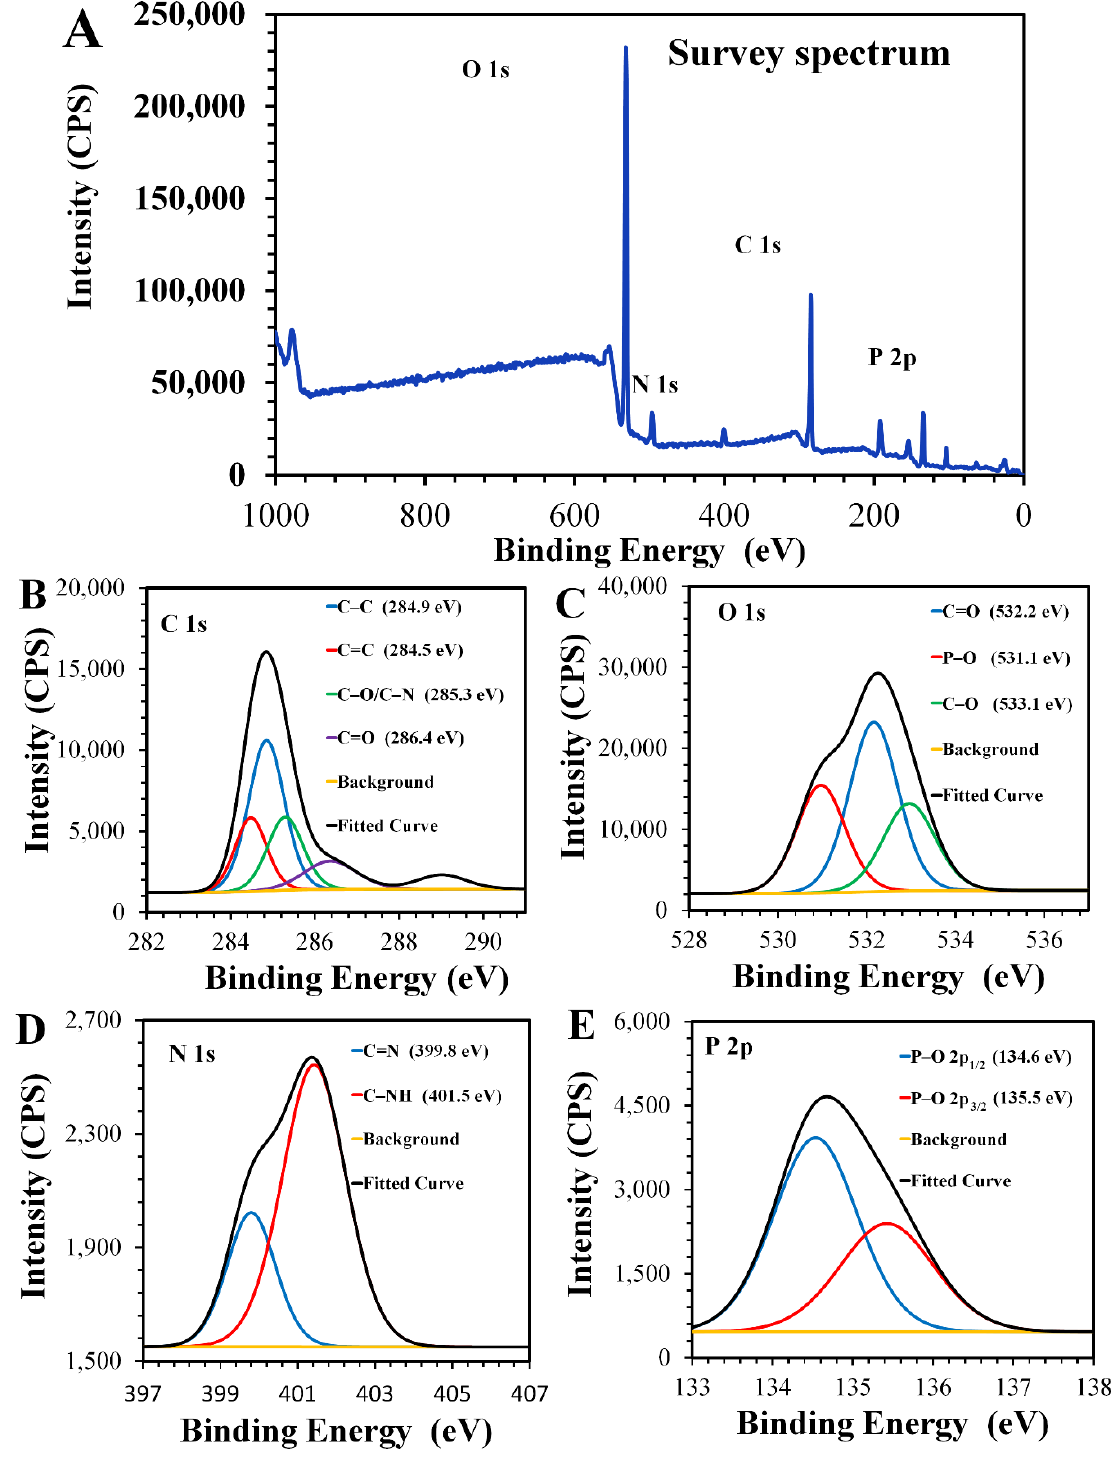
Figure 3. High-resolution XPS spectra of the CNDs: ( A ) survey spectra of CNDs and ( B − E ) deconvoluted XPS spectra for all elements in the CNDs.